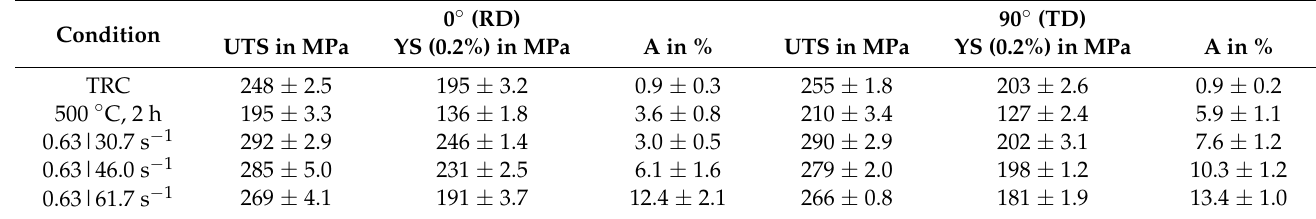
Table 4. Results of tensile testing at room temperature for TRC, homogenized, and hot rolled conditions tested in RD (0 ◦ ) and TD (90 ◦ ), average value of five samples.